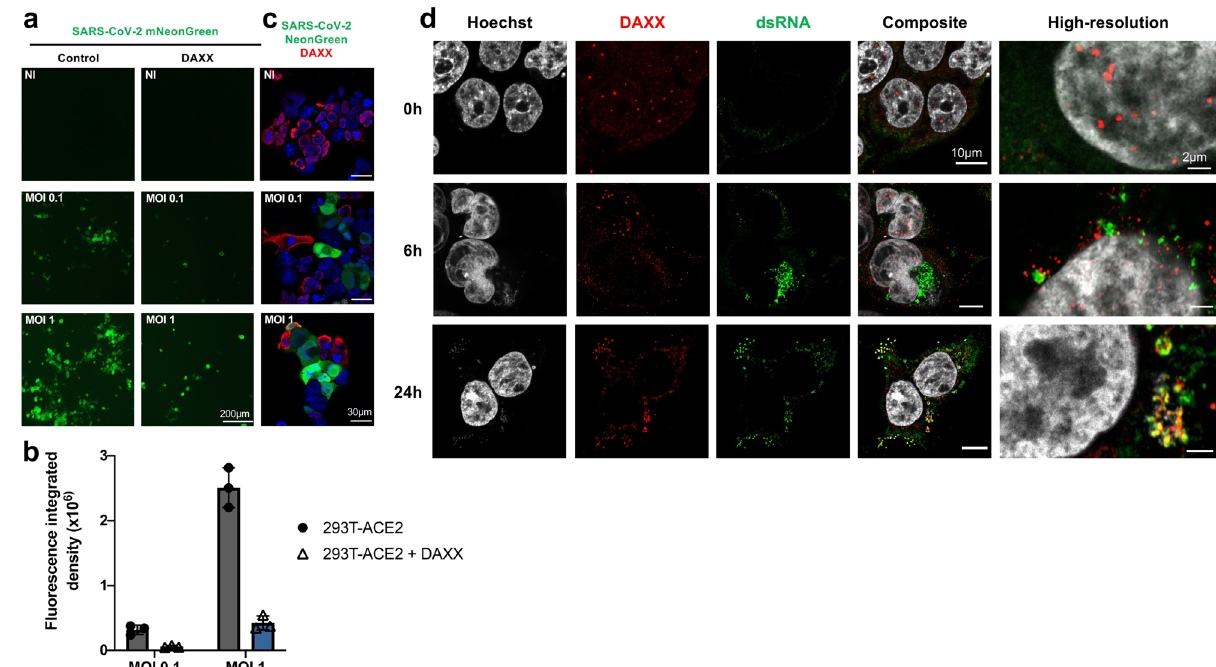
Fig. 5 SARS-CoV-2 infection induces DAXX cytoplasmic re-localization to sites of viral replication. DAXX overexpression restricts SARS-CoV-2. 293T- ACE2 cells were transfected with DAXX WT. 24 h after transfection, cells were infected with the mNeonGreen fl uorescent reporter SARS-CoV-2 at the indicated MOI. Cells were either visualized with an EVOS fl uorescence microscope ( a , b ) or stained with an HA-antibody detecting DAXX and imaged by confocal microscopy ( c ). Scale bars correspond to 200 µ m ( a ) and 30 µ m ( c ). Images shown in ( a ) were quanti fi ed using ImageJ software ( b ). Data shows the mean ± SD of Fluorescence integrated densities. The analysis was performed on around 200 cells from 3 different fi elds. Images are representative of 3 – 6 different fi elds from 2 independent experiments. d Relocalization of endogenous DAXX during SARS-CoV-2 infection. 293T-ACE2 cells were infected with SARS-CoV-2 at an MOI of 1. 24 h post-infection, cells were labelled with Hoescht and with antibodies against dsRNA (detecting viral RNA, in green) and HA (detecting DAXX, in red). When indicated, the high-resolution Airyscan mode was used. Scale bars correspond to 10 µ m for confocal images, and 2 µ m for the high-resolution images. Images are representative of 3 – 6 different fi elds from 2 independent experiments. Source data are provided as a Source Data fi